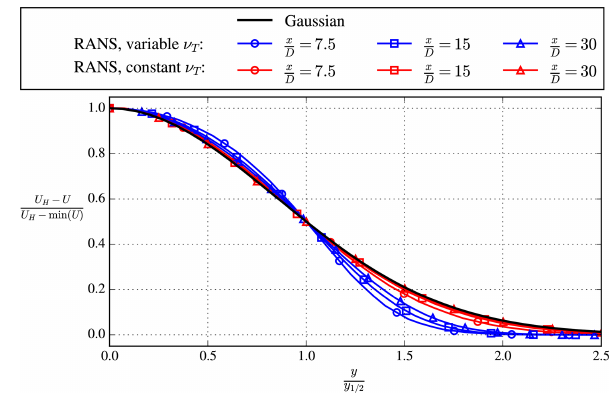
Figure A2. Self-similarity of the velocity deficit of a single wind turbine wake in